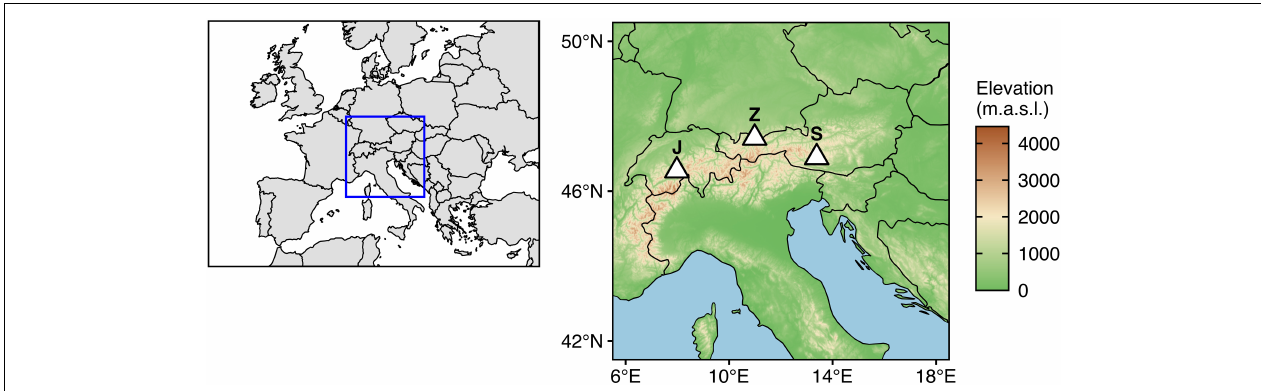
FIGURE 1 | Geographic locations of the study sites ( J : Jungfraujoch, 3572 m.a.s.l.; Z : Zugspitze, 2420 m.a.s.l.; S : Sonnblick, 3106 m.a.s.l.). Shapefiles for country borders were retrieved from Natural Earth (https://www.naturalearthdata.com/). Topographic data were retrieved from ETOPO1 Global Relief Model (Amante and Eakins, 2009) using metR (v. 0.9.2; Campitelli, 2021).